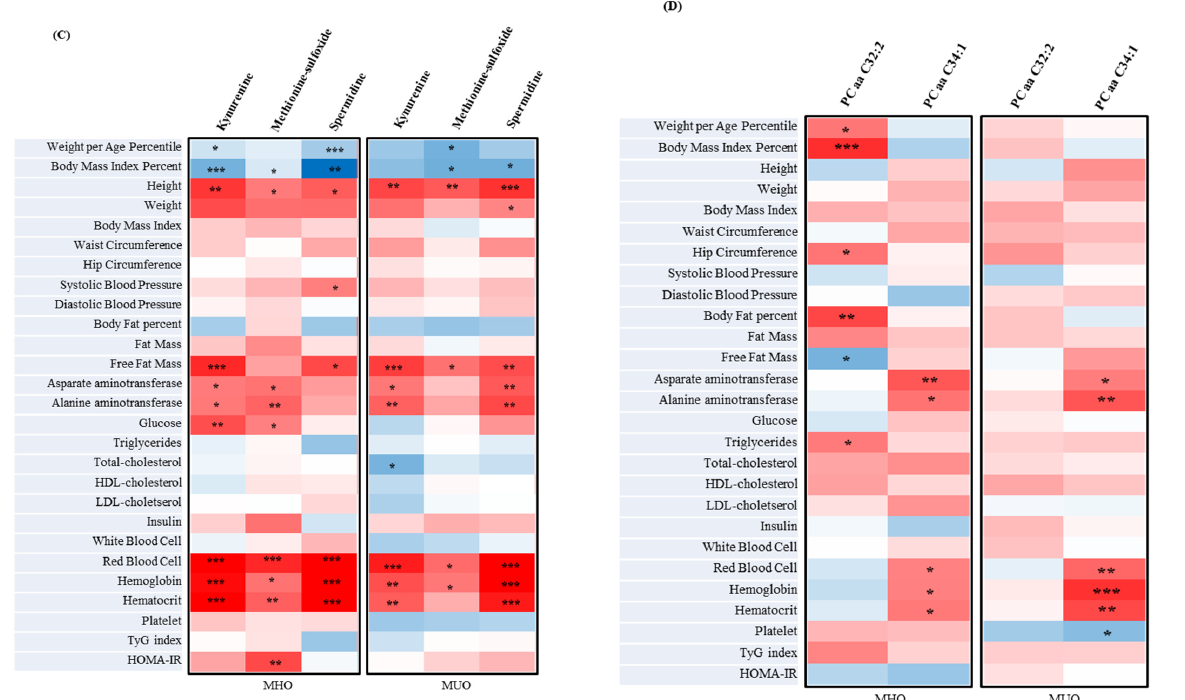
Figure 1. Correlation heatmap between metabolites associated with clinical parameters and IR assessment index in MHO and MUO. Correlation heatmap between 3 acylcarnitines ( A ) and 6 amino acids ( B ) associated with anthropometric parameters, and laboratory measurements in metabolically healthy obesity (MHO) and metabolically unhealthy obesity (MUO) groups. Partial correlation coefficient at the MHO and MUO. * p < 0.05, ** p < 0.01, and *** p < 0.001. Correlation heatmap between 3 biogenic amines ( C ) and 2 glycerophospholipids ( D ) associated with anthropometric parameters, and laboratory measurements in metabolically healthy obesity (MHO) and metabolically unhealthy obesity (MUO) groups. Partial correlation coefficient at the MHO and MUO. * p < 0.05, ** p < 0.01, and *** p < 0.001 PC, phosphatidylcholine; aa, diacyl.